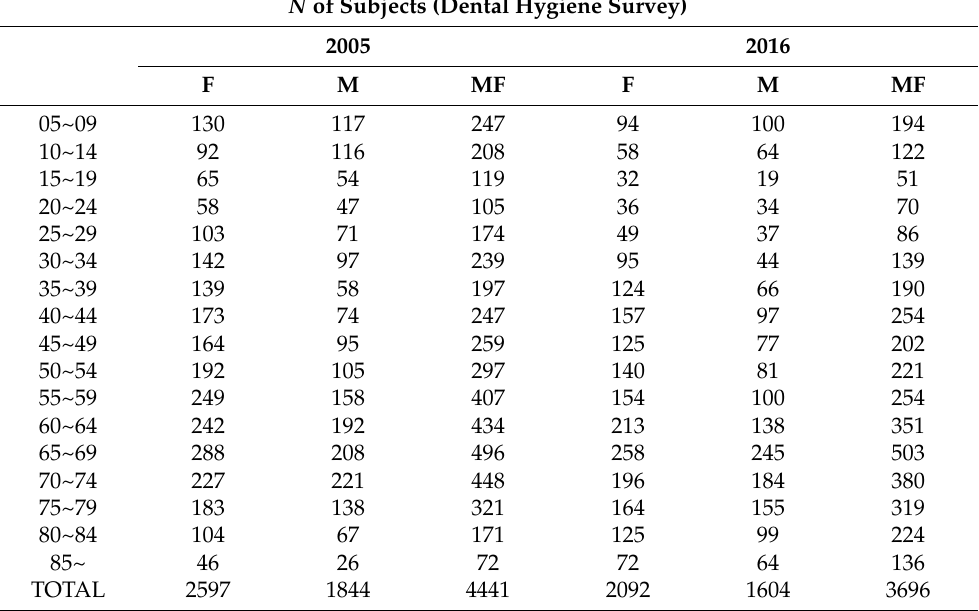
Table 1. The number of subjects of the Dental Hygiene Survey. N of Subjects (Dental Hygiene